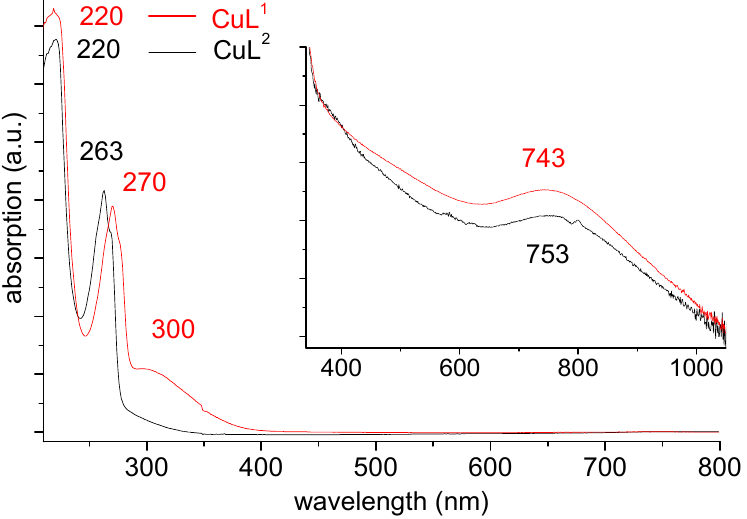
Figure 5. UV–vis absorption spectra of the complexes CuL 1 (L 1 = 2 ‐ bromo ‐ 5 ‐ methylpyridine and CuL 2 , L 2 = 2 ‐ bromo ‐ 4 ‐ methylpyridine, in EtOH solution. Conc. for the main spectra = 10 − 4 mol/L; conc. for the insert = 10 − 3 mol/L).